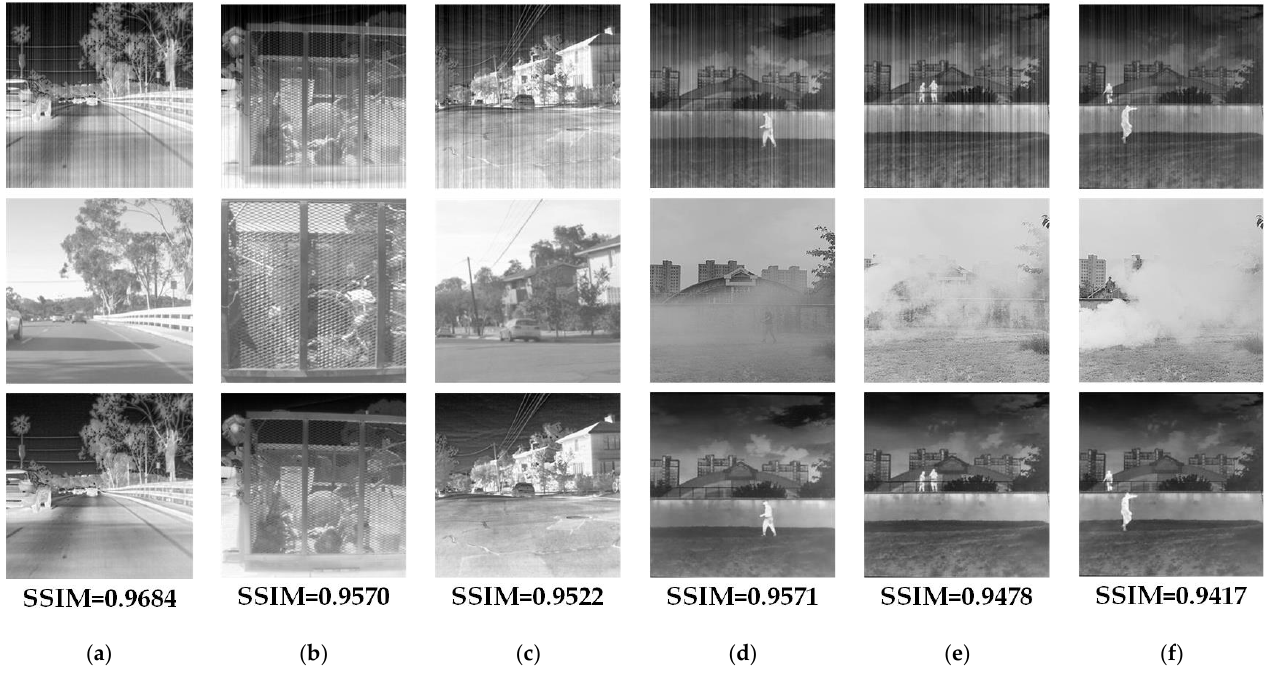
Figure 21. Correction results under different conditions. ( a ) Infrared and visible images are misregistered; ( b ) infrared and visible images are misregistered; ( c ) infrared and visible images are misregistered; ( d ) visible image has small area occlusion; ( e ) visible image has occlusion; ( f ) visible image has a large area of occlusion.